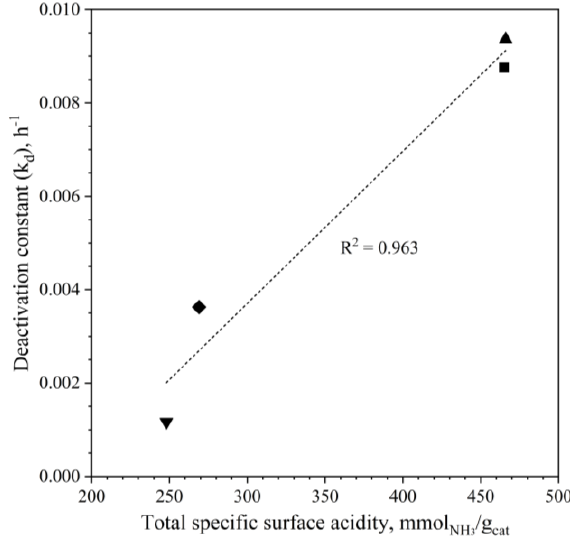
Figure 9. Relationship between the deactivation constant and the total specific surface acidity of the CuZnZr ferrierite-based hybrid catalysts ( ♦ CZZ/FER OX 2:1, ■ CZZ/FER OX 1:2, ▲ CZZ/FER WI ity of the CuZnZr ferrierite-based hybrid catalysts ( (cid:7) CZZ/FER OX 2:1, (cid:4) CZZ/FER OX 1:2, 1:2 and ▼ CZZ-FER MIX 1:2). (cid:78) CZZ/FER WI 1:2 and (cid:72) CZZ-FER MIX